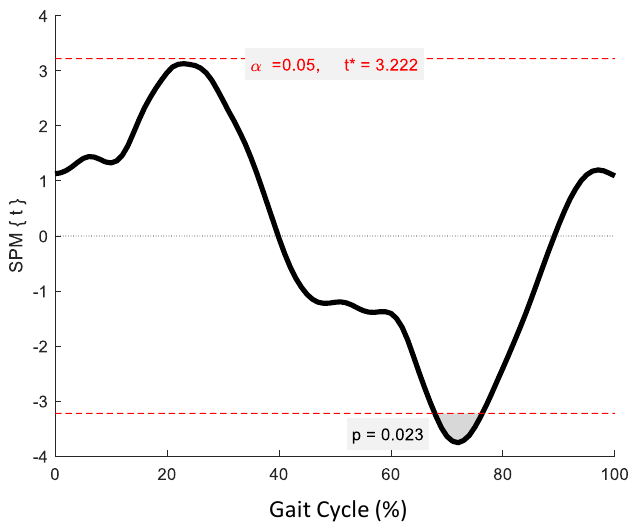
Figure 5. Statistical Parametric Mapping (SPM) output for pelvic kinematics in the transverse plane. The horizontal red dashed lines represent the critical t * based on α = 0.05 and random field theory calculations of residual smoothness. t * is the critical threshold.